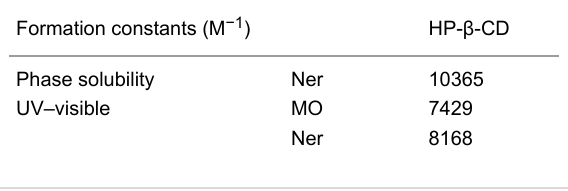
Table 2: Formation constants ( K f ) of HP- β -CD inclusion complexes with Ner obtained by phase solubility and UV-visible competition method.